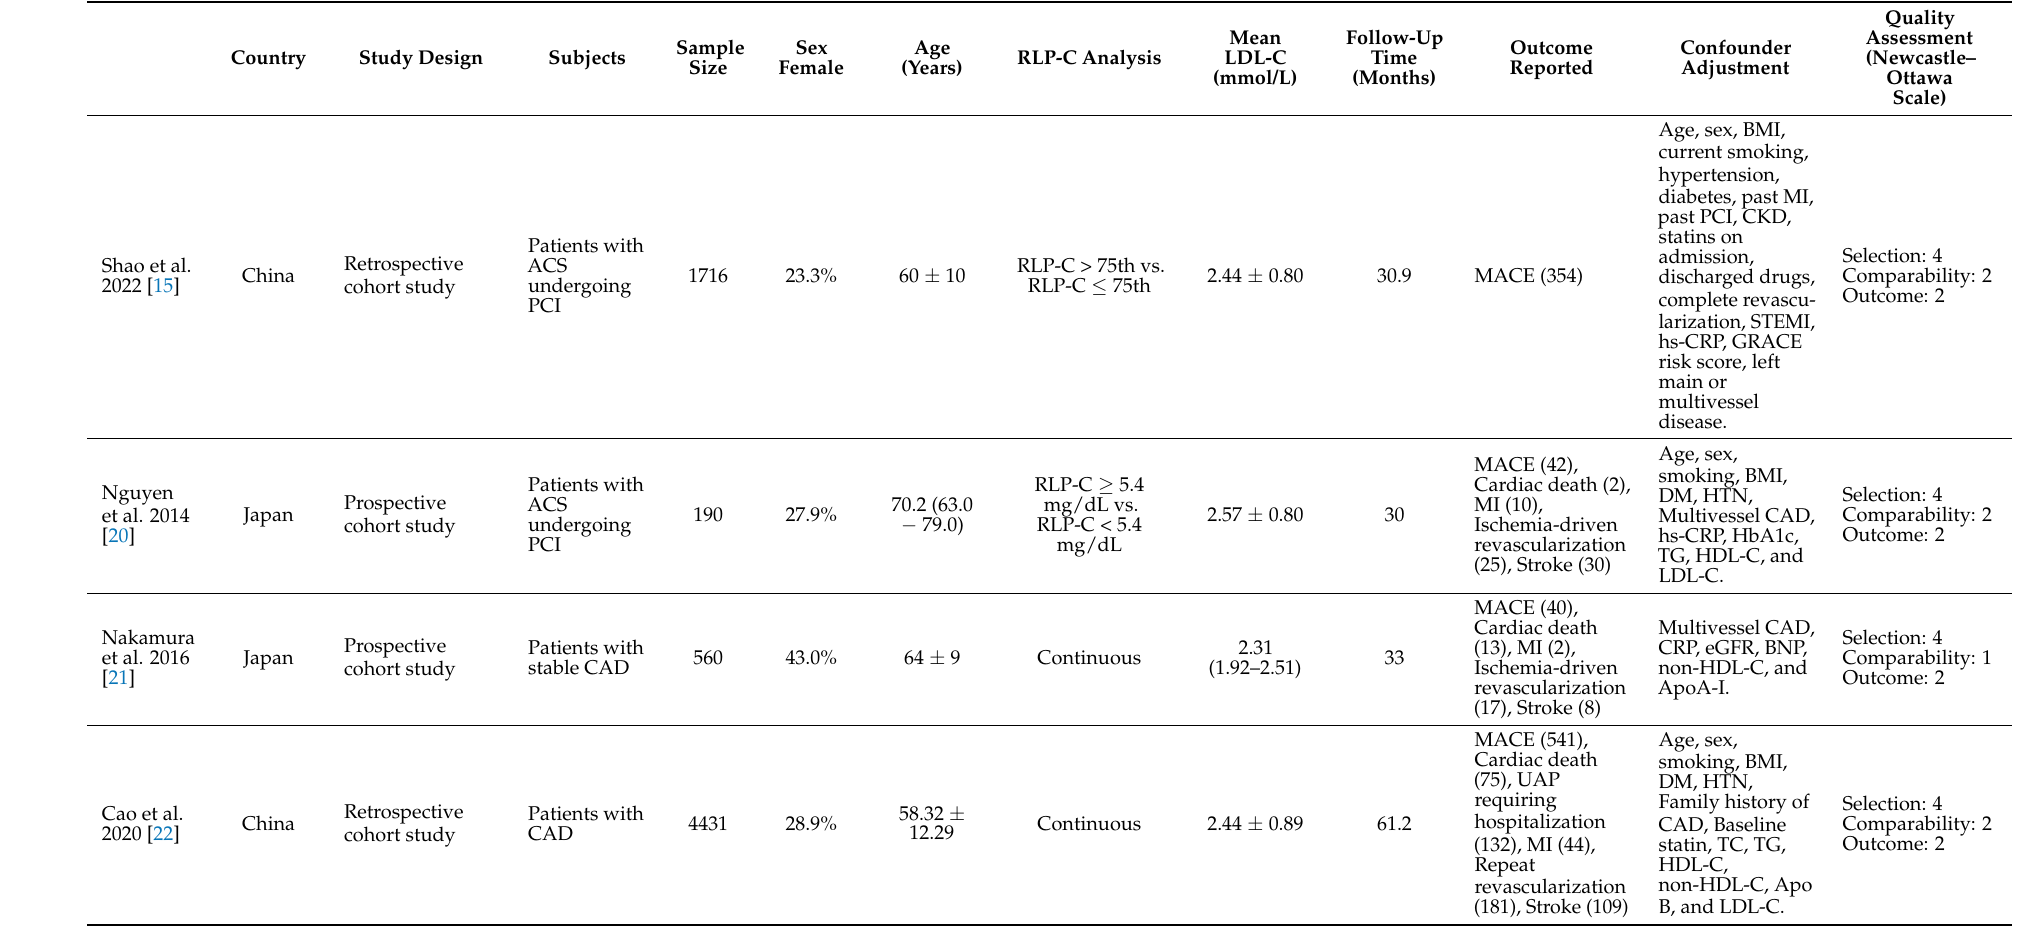
Table 1. Main characteristics of the studies included in this meta-analysis of the association between the RLP-C and